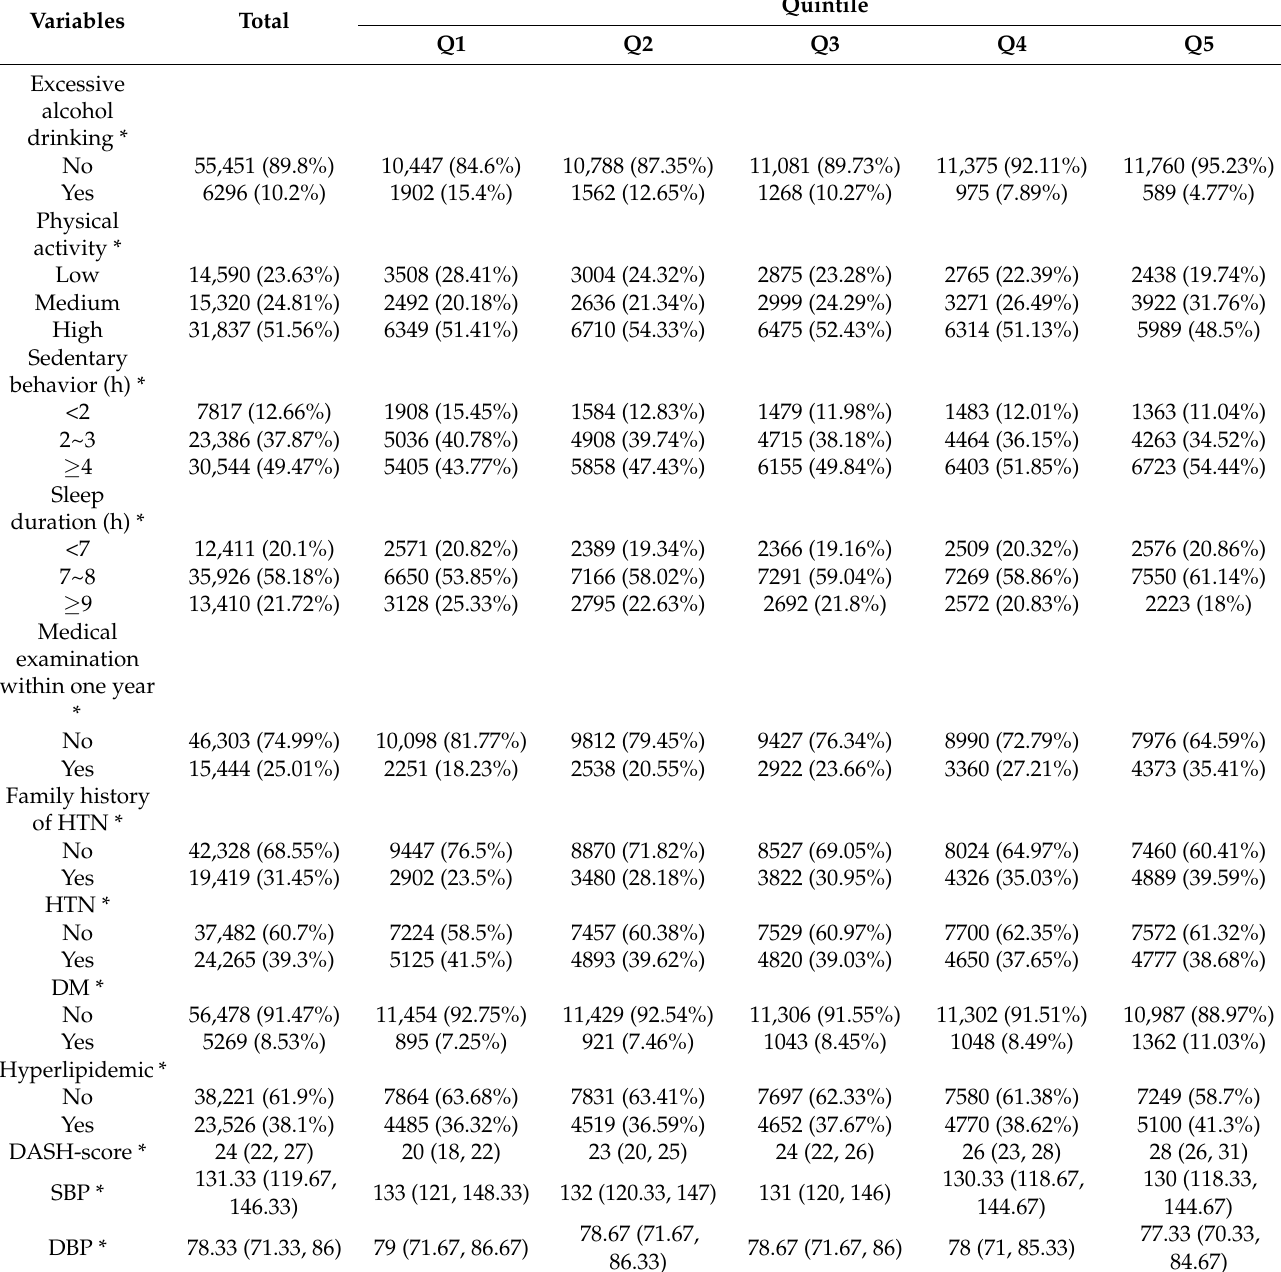
* Indicates p value < 0.05. Values of polytomous variables may not sum to 100% due to rounding. Continuous variables were described as median (P25, P75) due to abnormal distribution and categorical variables were described as amounts with